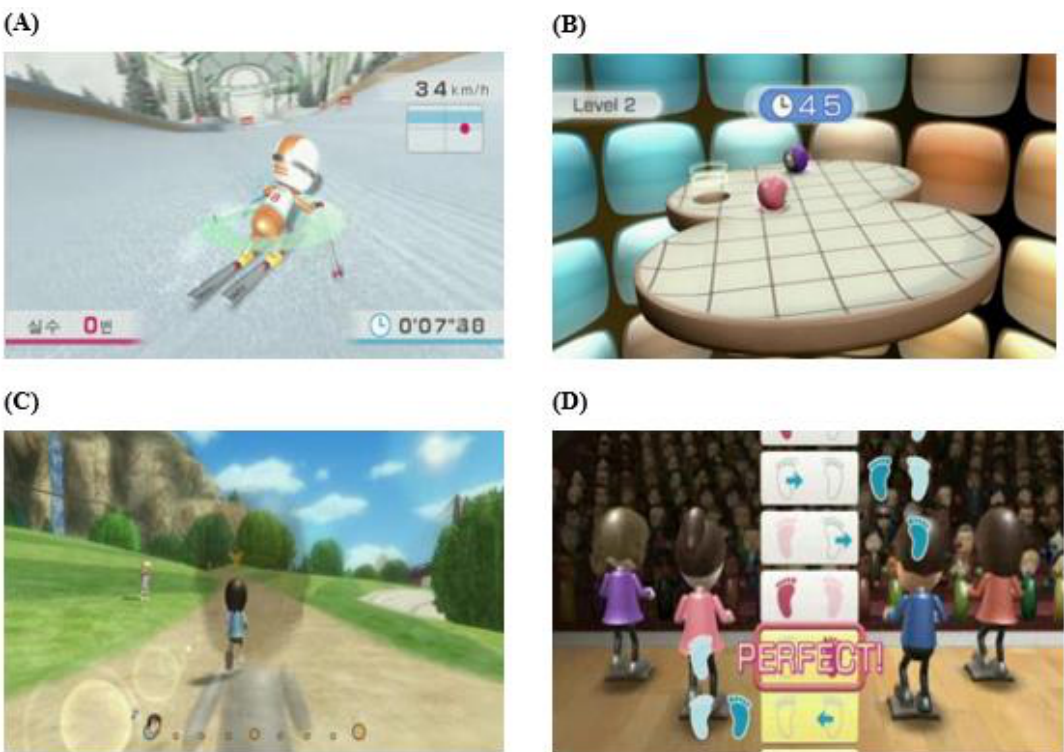
Figure 2. Virtual reality exercise program. ( A ) Balance ski; ( B ) Table tile; ( C ) Jogging; ( D ) Rhythm step.